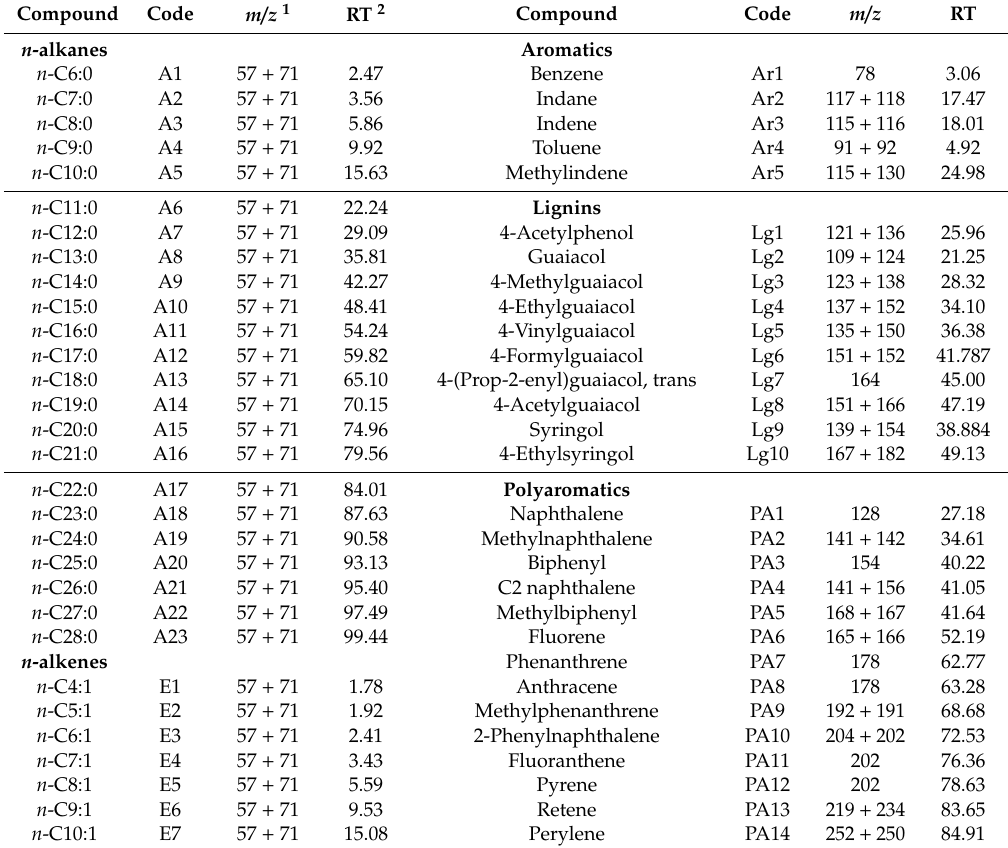
Table 1. Quantified pyrolysis products in the three